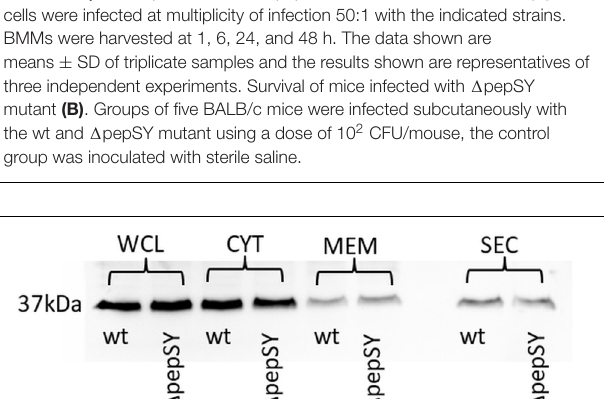
FIGURE 5 | Representative immunodetection of GapA protein (Mw 37 kDa) in whole-cell lysate (WCL), cytosol (CYT), crude membrane fraction (MEM), and culture filtrate protein (SEC) isolated from F. tularensis FSC200 wt or (cid:49) pepSY mutant strain. Protein samples (2 µ g of WCL and CYT, 40 µ g of MEM, 5 µ g of SEC for each strain) were separated on 12% SDS-PAGE. Western blots were probed with polyclonal rabbit anti-GapA antibody (Apronex), imaged and analyzed using the iBright Imaging System